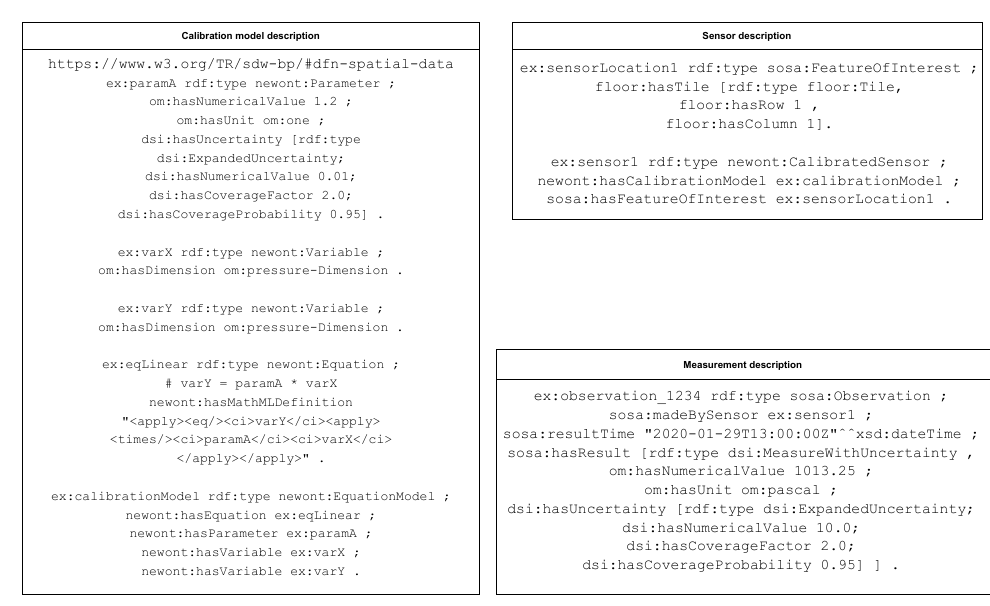
Figure 7. Definitions of the calibration, sensor and measurement models in OWL notation. The prefixes refer to the specific ontologies